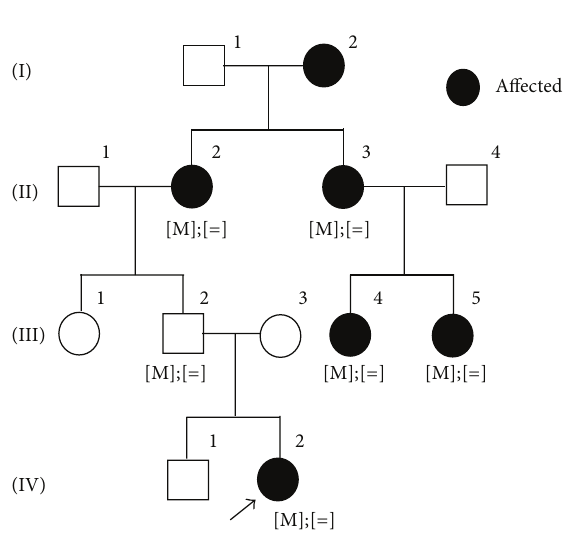
Table 5: In silico analysis for novel missense mutations.